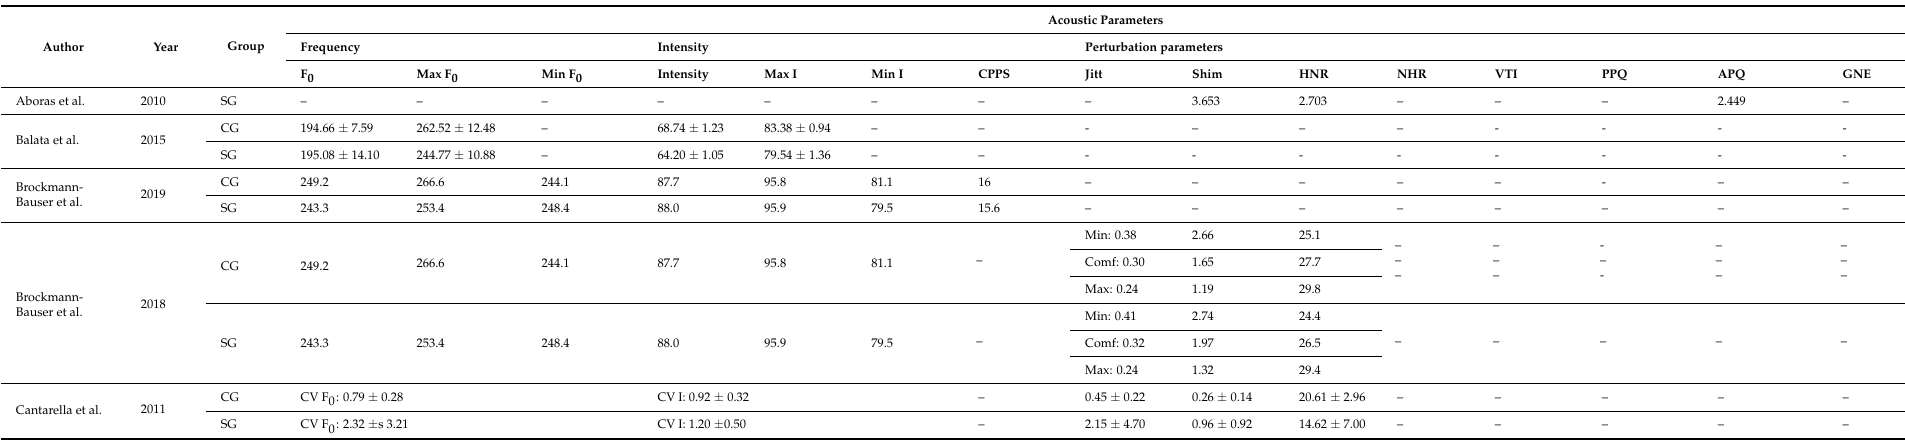
Table 4. Summary of the results of the included studies in terms of acoustic